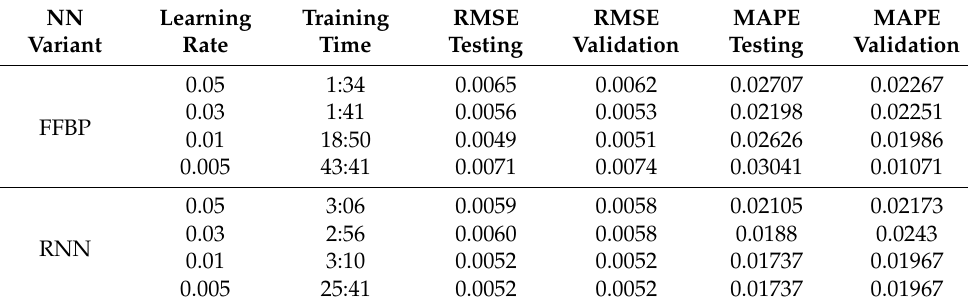
Table 5. Training and testing results of FFBPNN and RNN for case 2